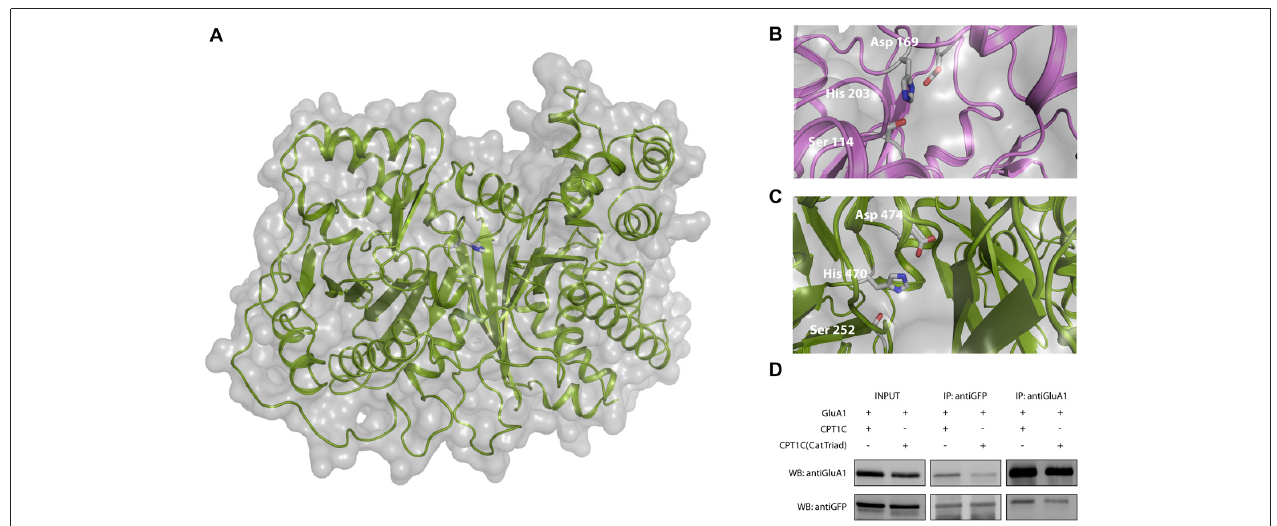
FIGURE 2 | Identification of a putative catalytic triad in CPT1C. (A) Molecular model of human CPT1C based on the determined structure of human carnitine acetyltransferase. Residue His 473, conserved among CPTs (His 470 in CPT1C), is displayed in sticks. (B) Structure of acyl protein thioesterase 1 (APT1; PDB ID 1FJ2). Ser 114, His 203 and Asp 169 from the catalytic triad are displayed in sticks. (C) CPT1C molecular model. Ser 252, His 470 and Asp 474 putative catalytic residues are displayed in sticks. The putative catalytic residues in CPT1C were identified based on the relative disposition of the catalytic residues in the structure of APT1. (D) Coimmunoprecipitation showing that mutated CPT1C(S252A, H470A, D474A)-GFP—CPT1C(CatTriad)—does not affect the interaction with GluA1. Anti-GFP antibodies pull-down GluA1 when expressed together with CPT1C(CatTriad), (middle lanes, upper panel). GluA1 recognizing antibodies pull down CPT1C(CatTriad), (right lanes, lower panel). This experiment was replicated three